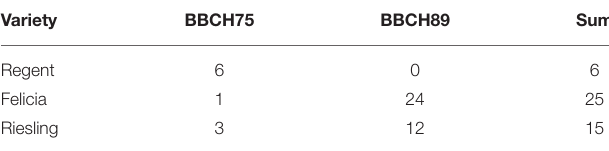
TABLE 2 | Overview of images showing damaged